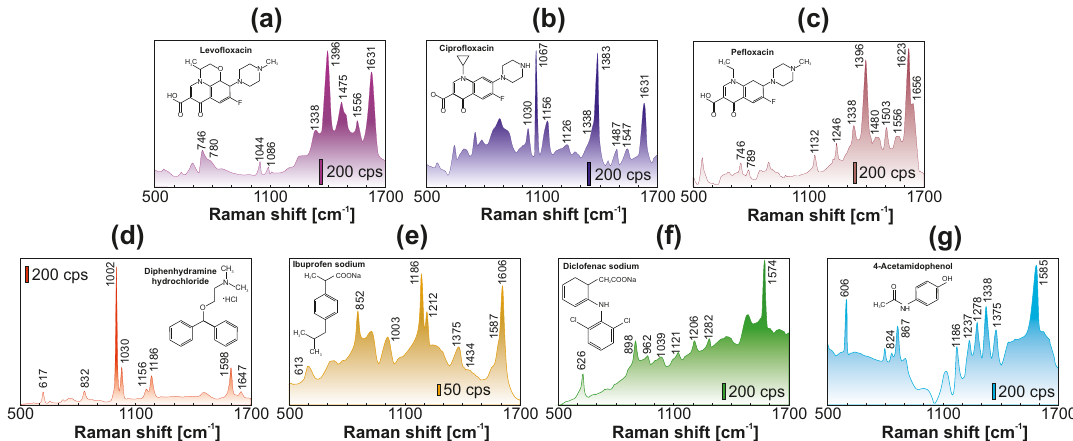
Figure 5. SERS spectra of ( a ) levofloxacin, ( b ) ciprofloxacin, ( c ) pefloxacin, ( d ) diphenhydramine hydrochloride, ( e ) ibuprofen sodium, ( f ) diclofenac sodium, ( g ) 4-acetamidophenol. Each analyte was deposited onto plasmonic site from an evaporating water droplet (5 µ L) containing 10 − 8 M of detected substance. Each spectrum was averaged over at least 30 similar spectra measured at various detection sites. Pump intensity was fixed at 0.9 mW/ µ m 2 and 785 nm as pump wavelength. Signal accumulation time was 1 s for all